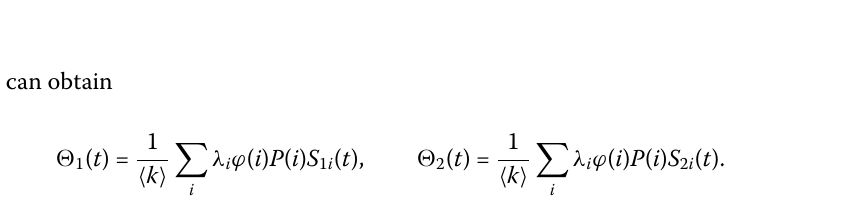
Table 1 The meaning of the parameters in model (1) Parameters Meaning b the coming rate of ignoramuses μ the removal rate of the different compartment α the probability of exposed with language-1 based β h the transformation rate from exposed to spreaders-1 γ h the transformation rate from exposed to spreaders-2 δ the transfer rate from spreaders to stiflers due to forgetting or educational mechanism